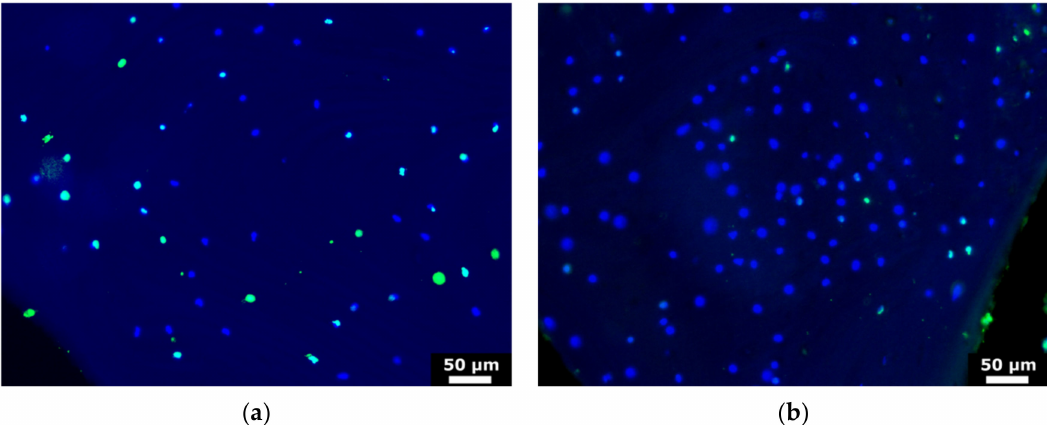
Figure 7. Microscopic images of the ( a ) longitudinal and ( b ) transversal view of bone cylinder stained with TUNEL assay. The viable osteocytes are labeled blue, dead osteocytes are labeled